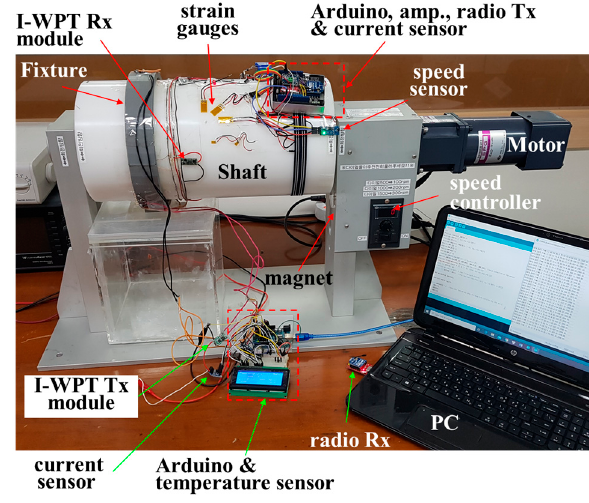
Figure 4. The WSS installed on the test bench system.